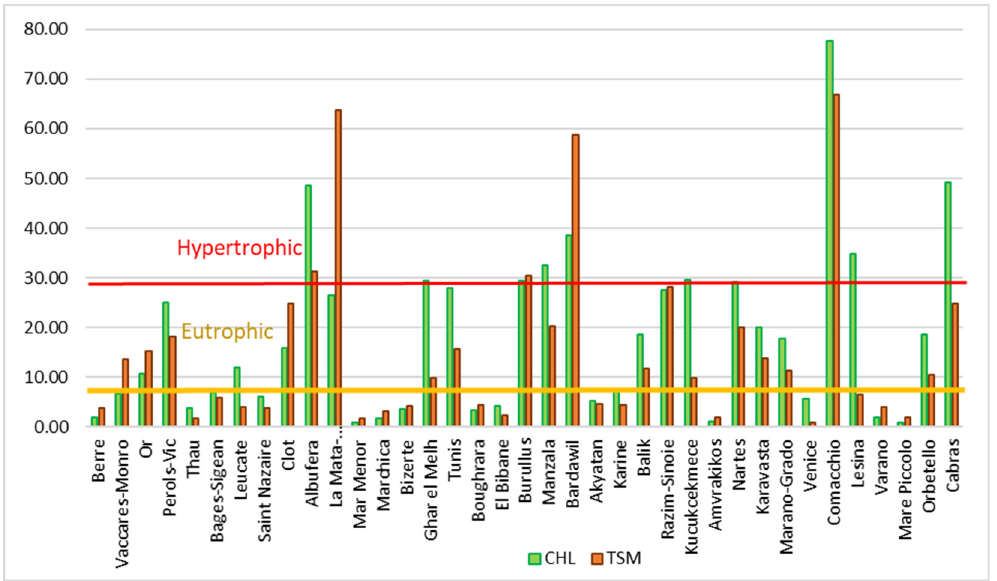
Figure 5. Trophic status of coastal lagoons assessed by chlorophyll a concentration in summer 2020. Chlorophyll a concentration (CHL) in mg/m 3 and TSM concentration in mg/L.